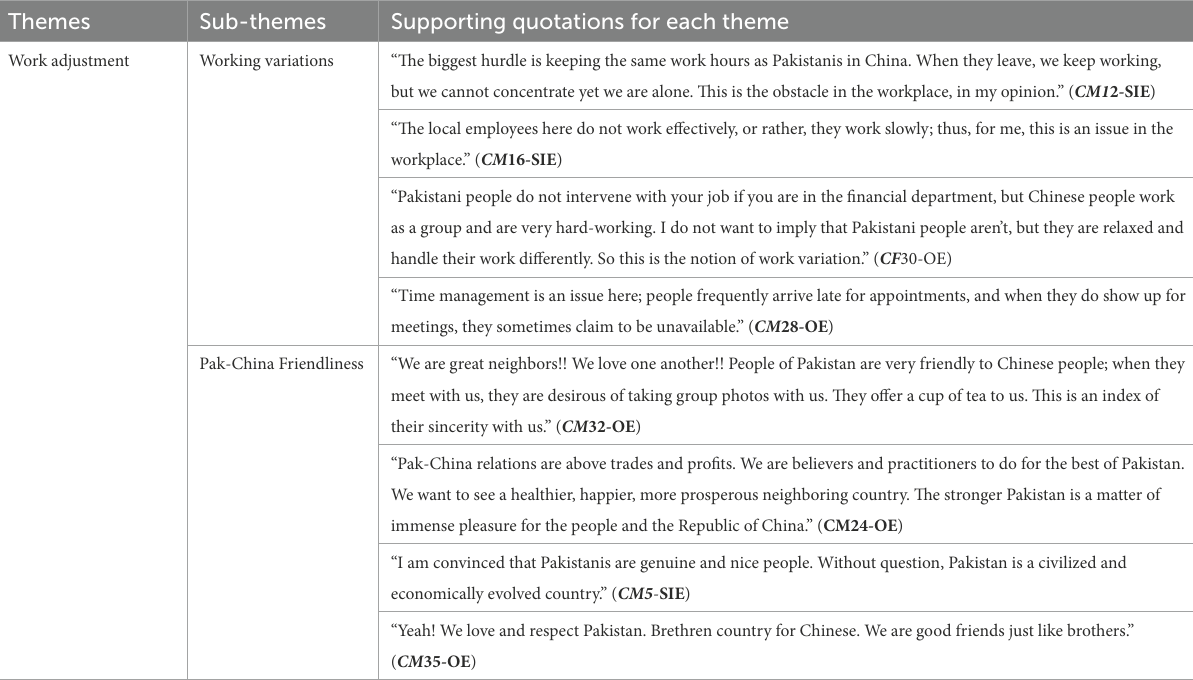
TABLE 4 Work adjustment themes and